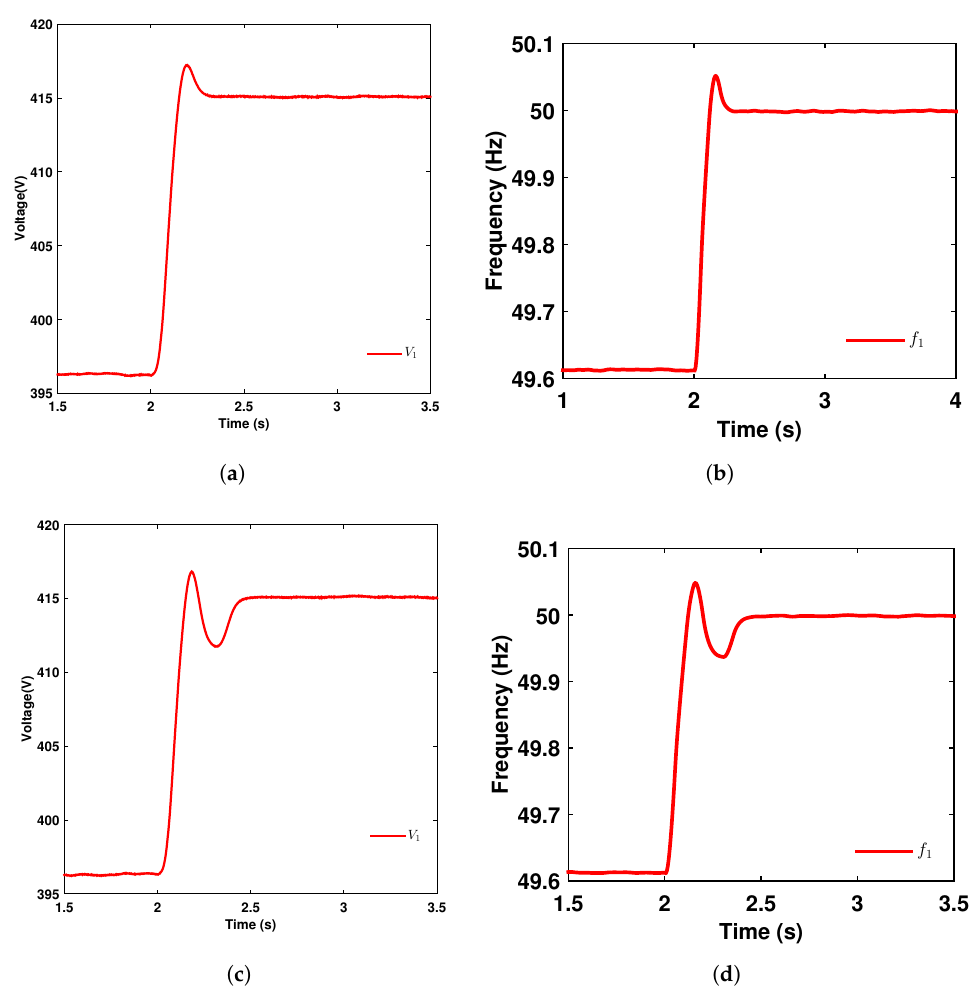
Figure 11. Performance under link delay. ( a ) Voltage under link delay τ d = 1 s. ( b ) Frequency under link delay τ d = 1 s. ( c ) Voltage under link delay τ d = 2 s. ( d ) Frequency under link delay τ d = 2